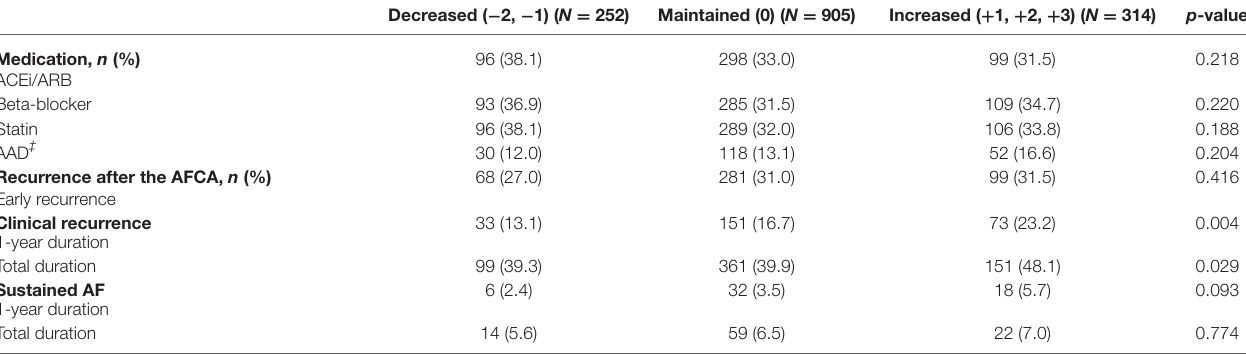
Frontiers in Cardiovascular Medicine |